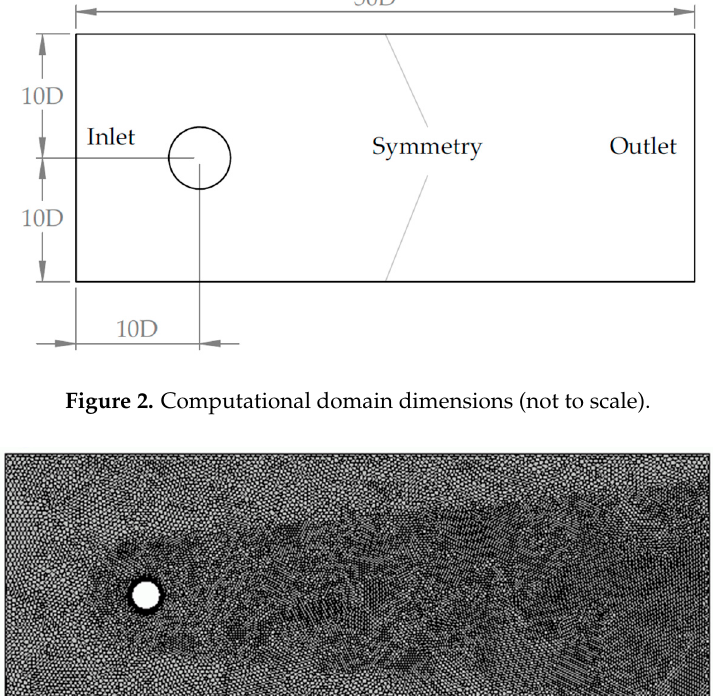
Figure 2. Computational domain dimensions (not to scale).